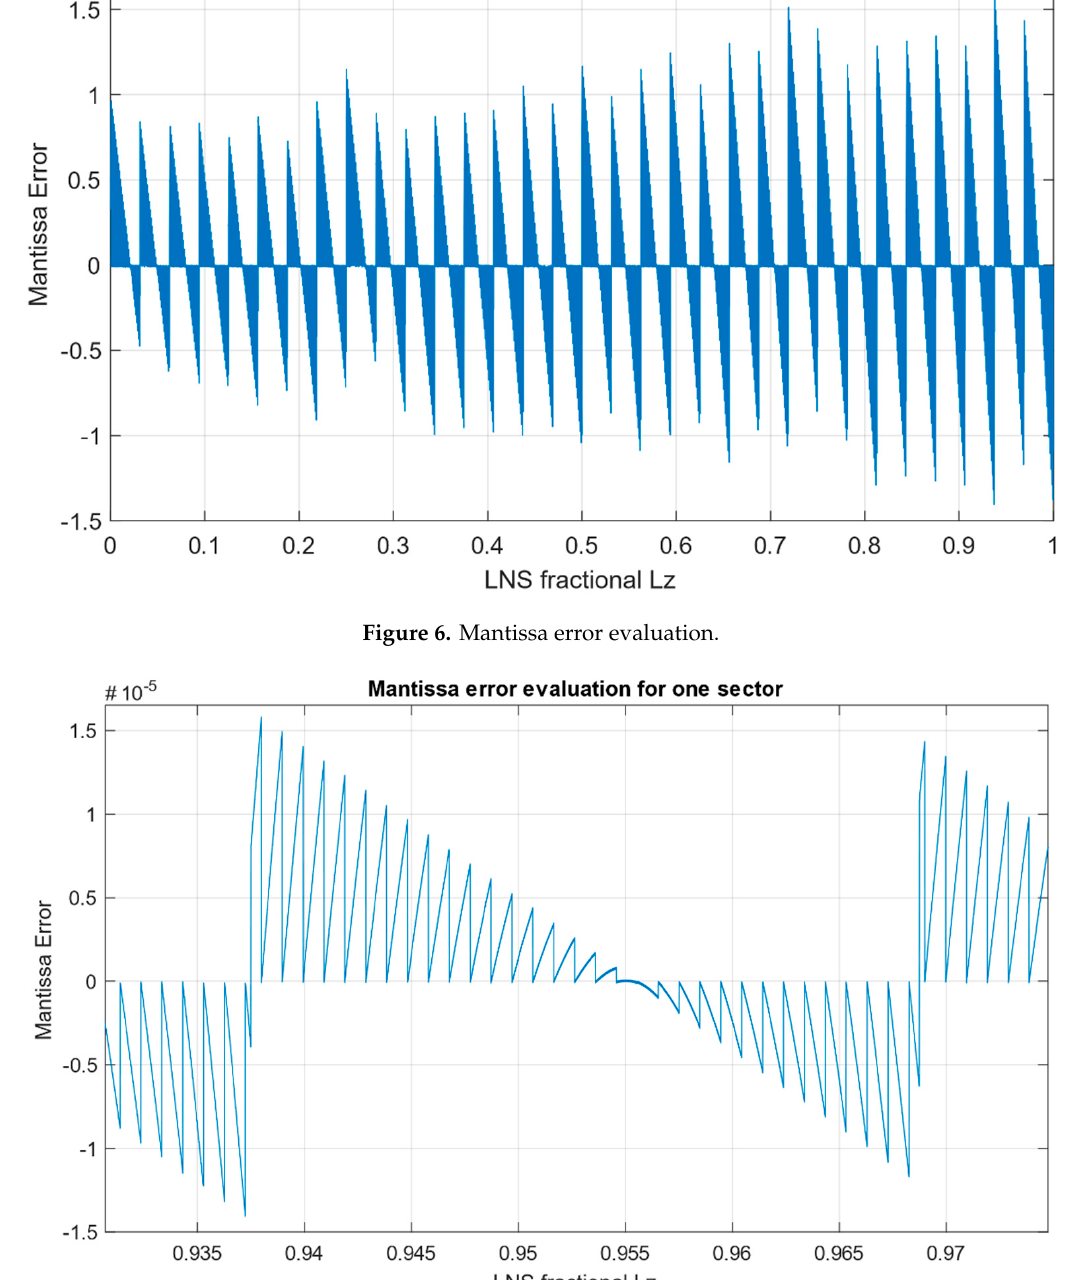
Table 6. Comparison of accuracies achieved using the proposed LiS method with selected conversion methods.